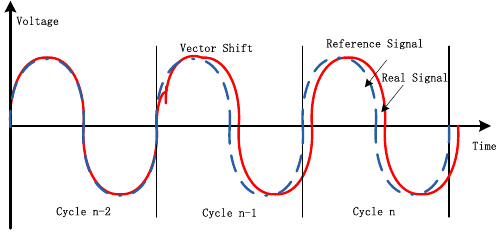
Figure 5. Phase angle change calculation based on Discrete Fourier Transformer (DFT).